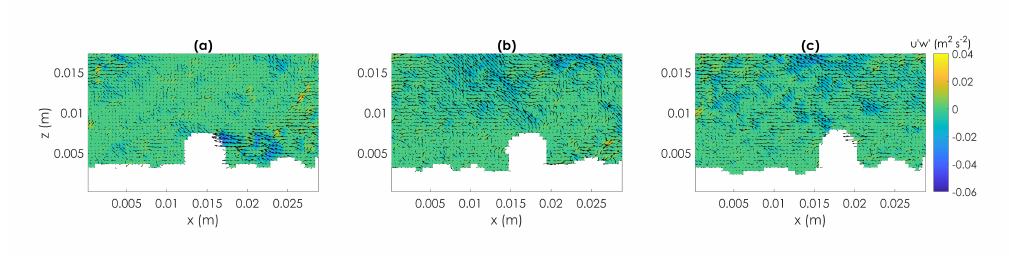
Figure 21. Particle deposited because of hydrodynamic forces (particle 1, Test T1). Sequence of three PIV images respectively showing (From ( a – c )): at time t = t 0 (2 time instants, corresponding to 0.1333 s, before disentrainment) the particle is in motion within the field of view; at time t = t 0 + ∆ t (1 time instant, corresponding to 0.067 s, before disentrainment) the particle is approaching its rest location; at time t = t 0 + 2 ∆ t the particle is at rest in the bed.